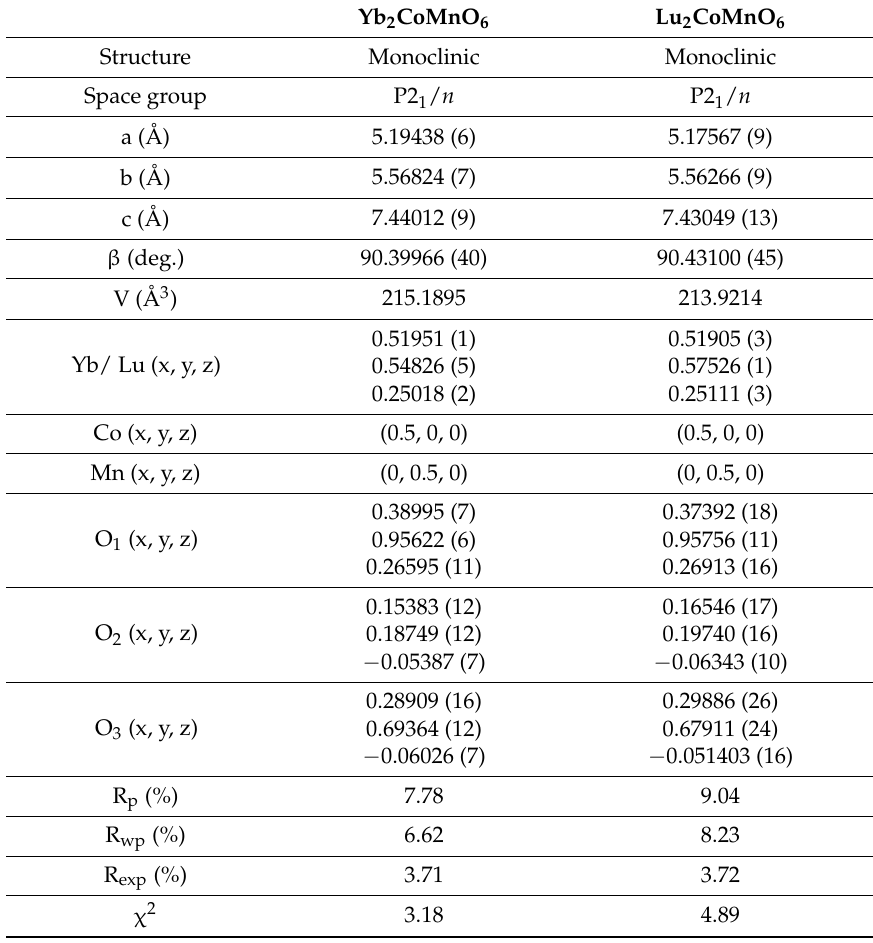
Table 1. Unit cell parameters, positional parameters, and reliability factors for YCMO and LCMO.